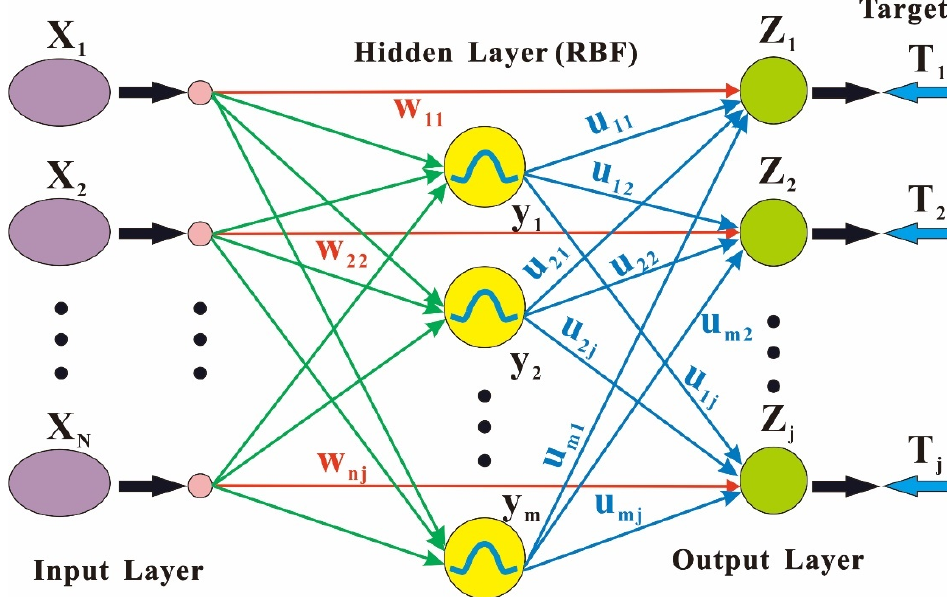
Figure 4. Architecture diagram of RBFLN (modified from [34]).